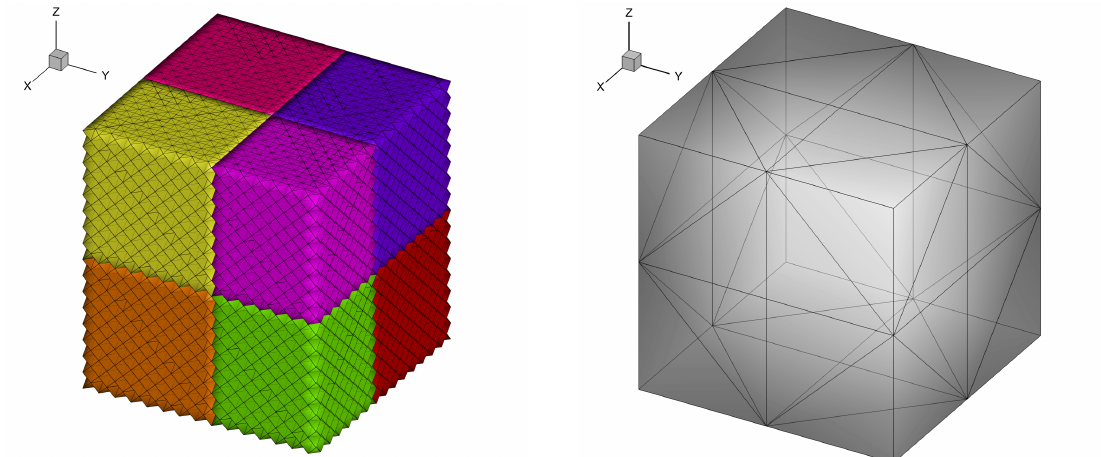
Figure 3. ( Left ): Split-Cartesian mesh of 32 3 hexahedra and 2 3 MPI ranks. ( Right ): Detail of the division of hexahedra into